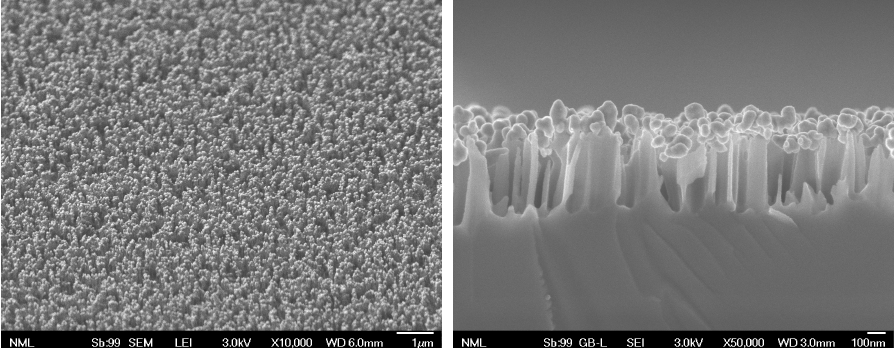
Figure 3. SEM micrographs of Ag-aggregate samples on the SiNWs, ( left ): top view (scale bar: 1 µ m), ( right ): cross section (scale bar: 100 nm). The Ag-aggregates grow at the tips of the